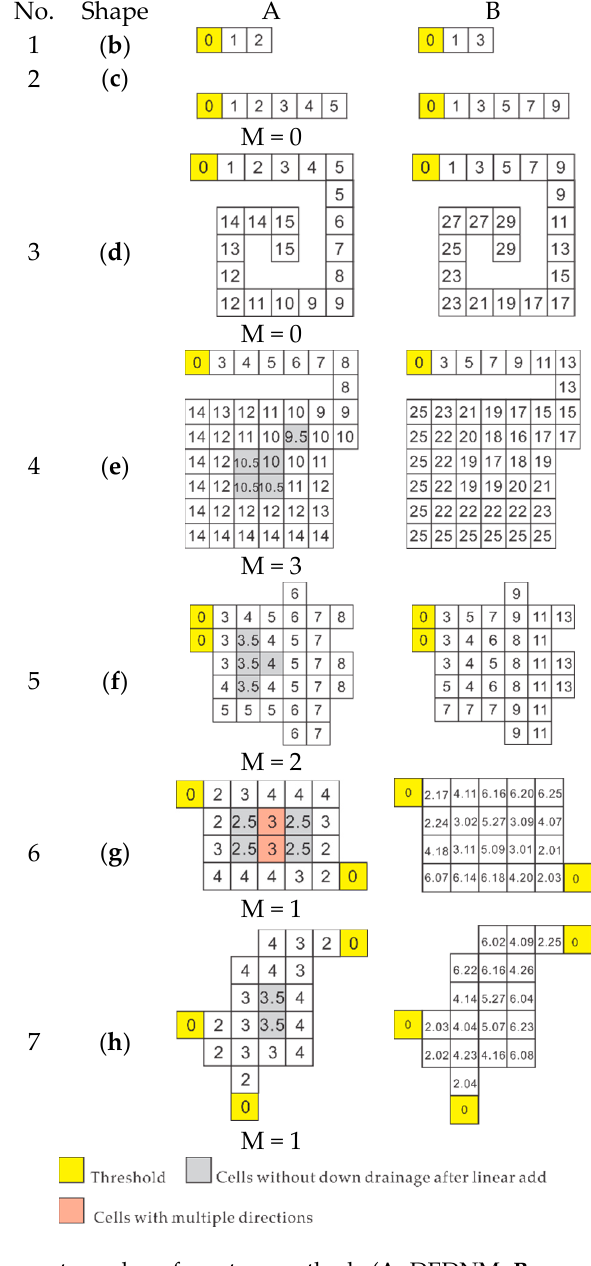
Figure 9. Final increment numbers from two methods ( A : DEDNM; B : new algorithm) for seven different flat surfaces ( b – h ) (note that M represents the repeating times to correct no drainage cells in DEDNM).